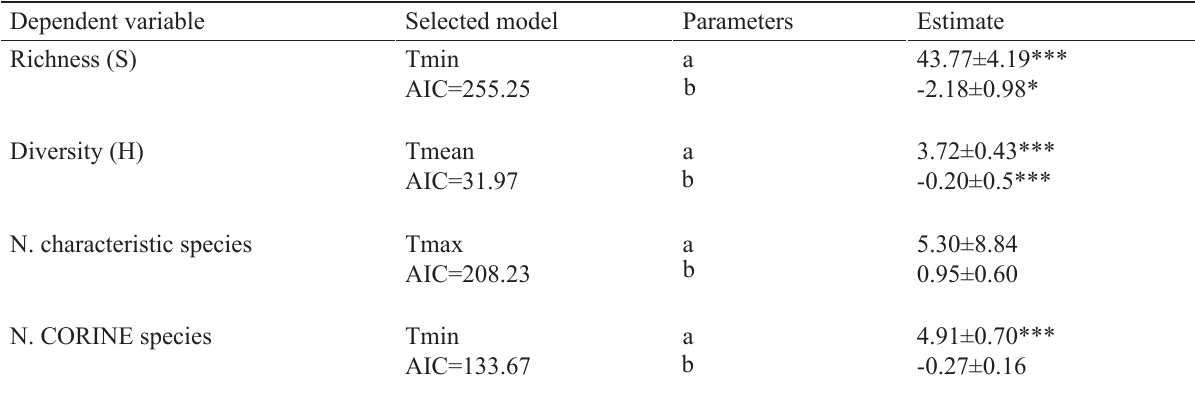
Table 2. Mean values (±SE) for each estimated parameter in the selected models for evaluating the effect of environmental variables on conservation indicators. The parameters are the interception (a) and the slope (b). For all models, the significance (*): p < 0.05; (**): p < 0.01; (***): p <